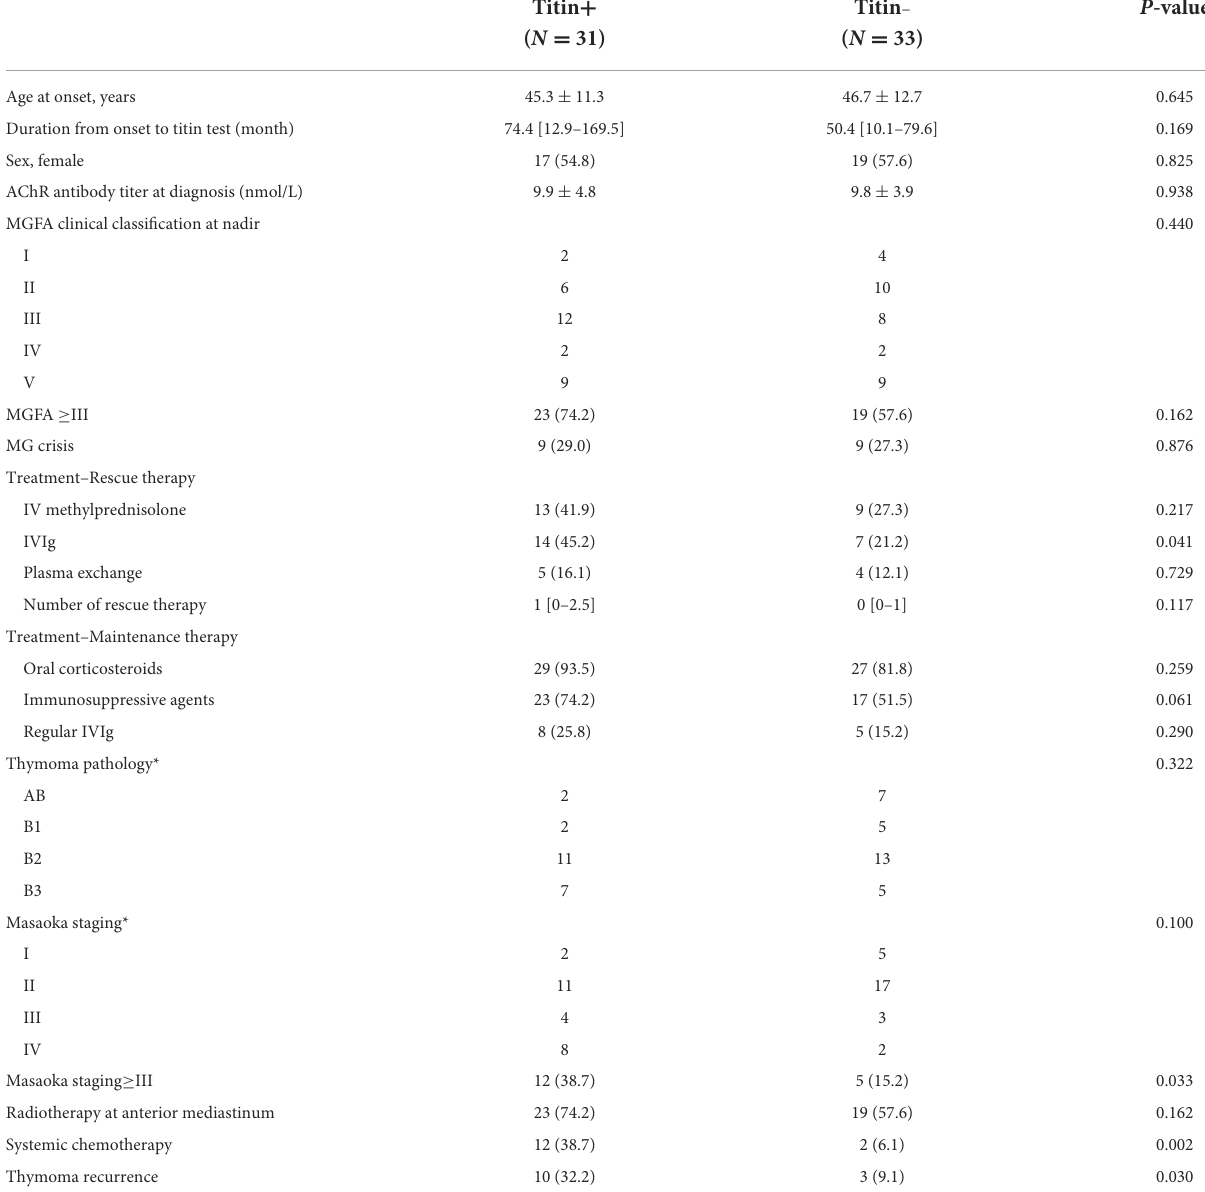
Titin + Titin – P -value ( N = 31)